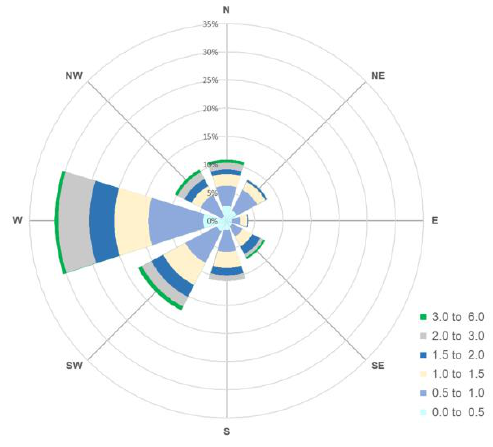
Figure 4. Wave rose for year 2012 (significant wave heights) at ERA-Interim grid point.